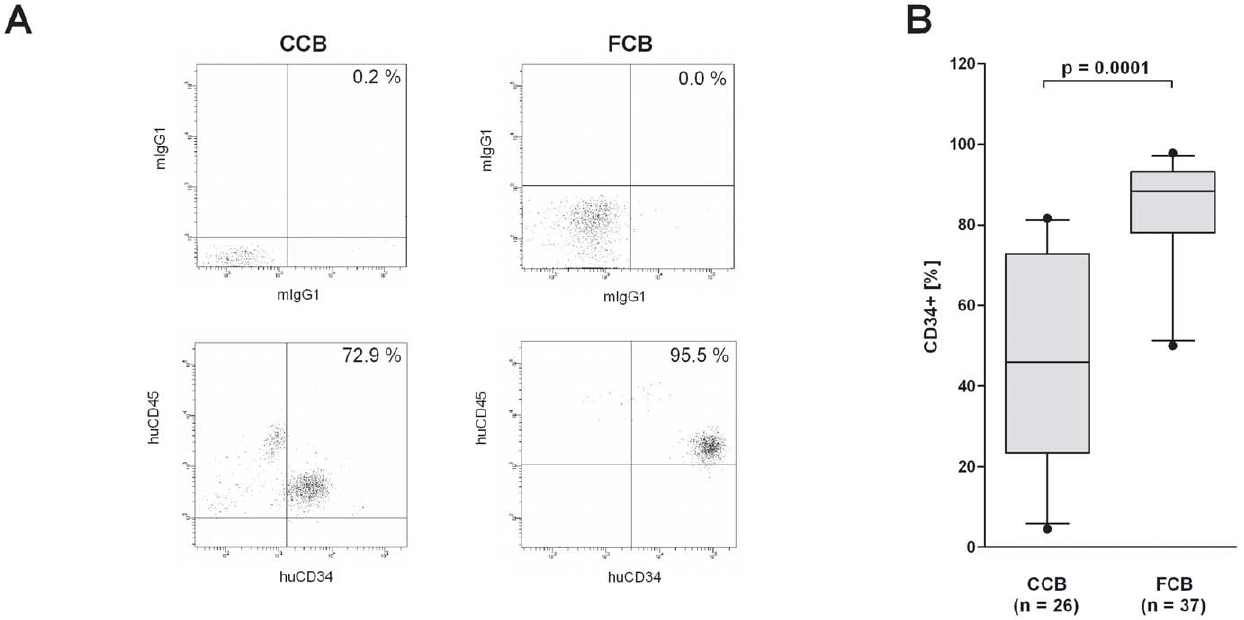
Figure 2. Differences and parallelism in the purity of CD34 + -cell-purifications from FCB and blood bank CCB. (A) MNC were isolated from FCB and blood bank CCB by washing with DNAse buffer or Ficoll-paque density gradient centrifugation as described in materials and methods. CD34 + stem cells were isolated from MNC by a positive magnetic separation of CD34 + cells and the purity was analyzed by flow cytometry. Dot plots depict the percentage of CD34 + cells of one representative separation from CCB and FCB (lower panels). The quadrant was set according to the isotype controls (upper panels). (B) The bar chart depicts the percentage of CD34 + cells after isolation of CD34 + cells from 26 CCB and 37 FCB samples. Box plots depict median and 5–95% percentile. Level of significance is given. n. s.=no significance.